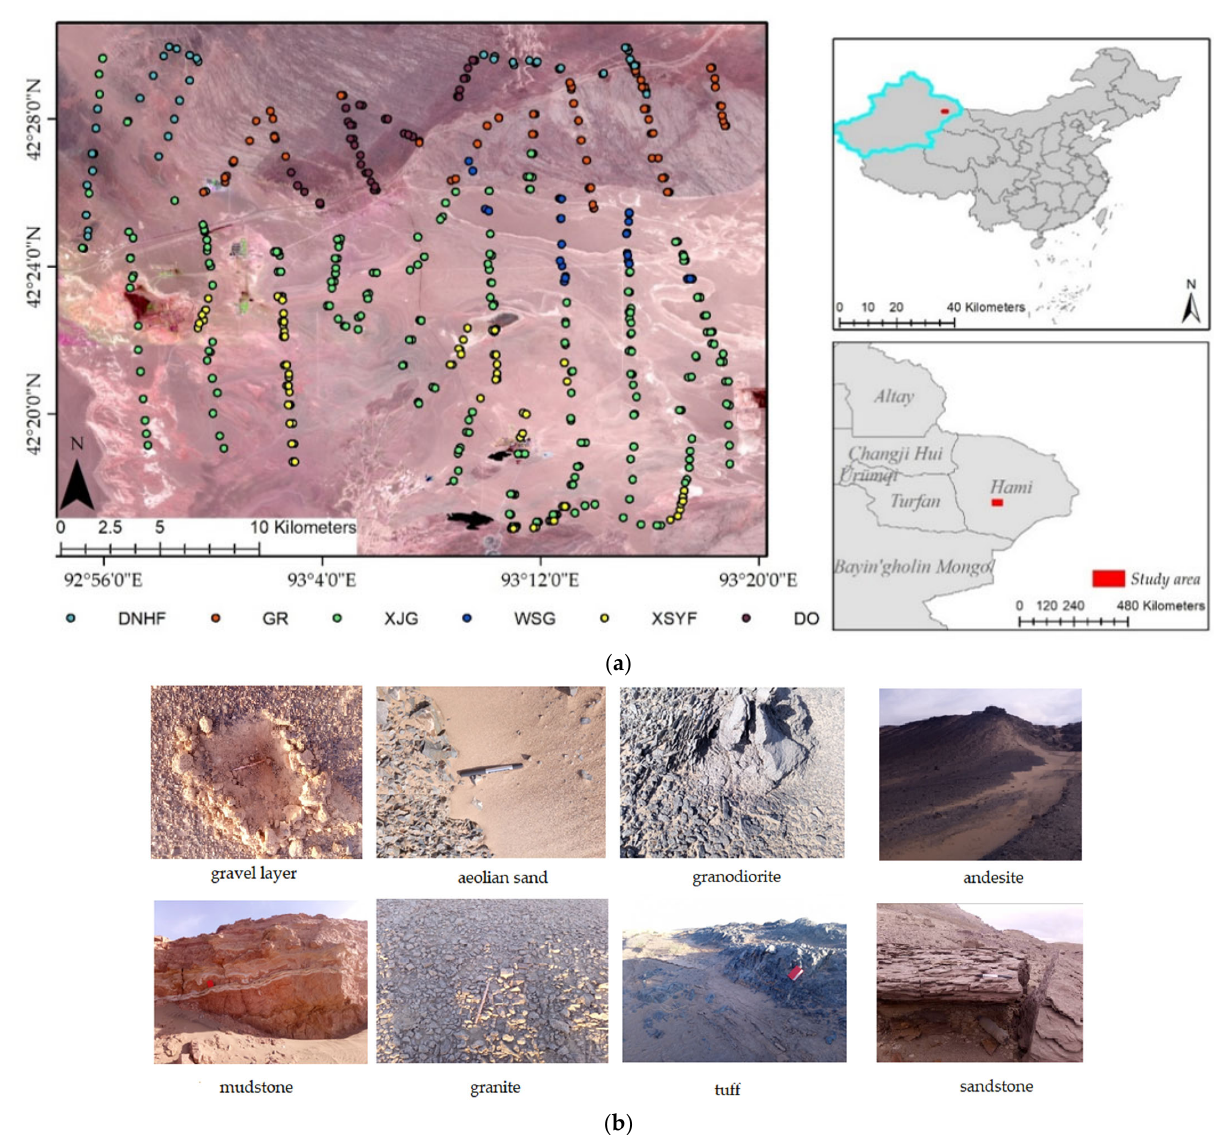
Figure 1. ( a ) Study area (the background is a mosaic Sentinel ‐ 2 image acquired around June 2020) and field survey sample distribution; ( b ) photos of typical lithology found during the fieldwork.